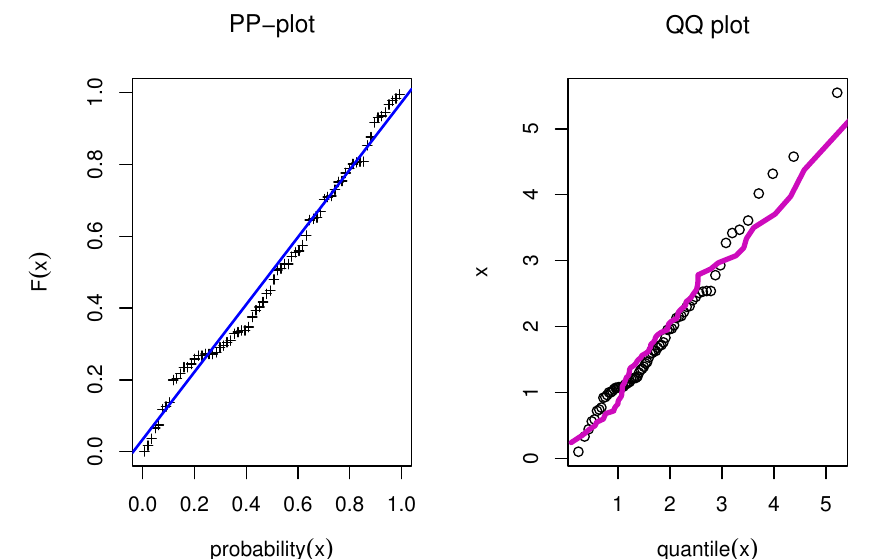
Figure 13. PP and QQ for TLMW model for Guinea Pigs data.